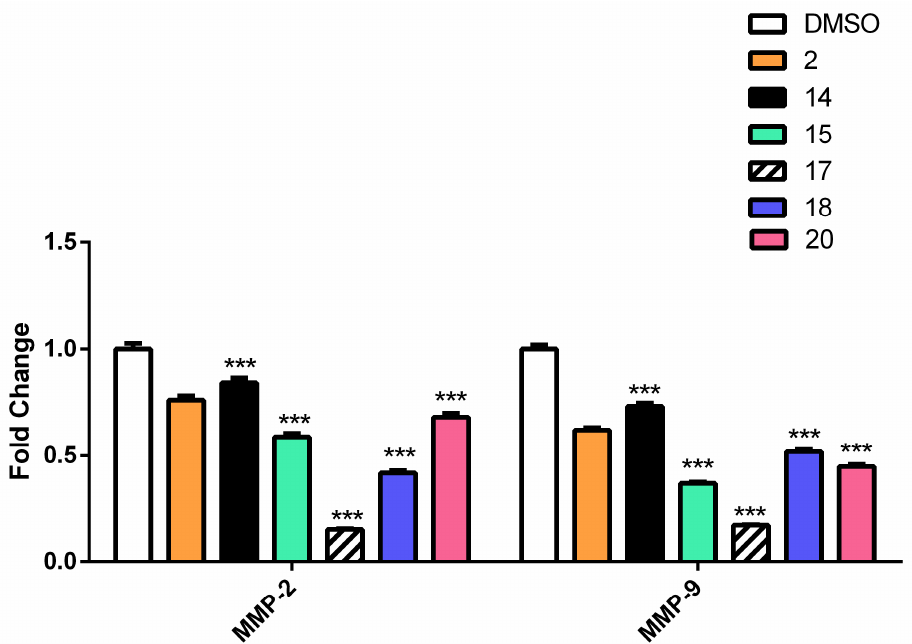
Figure 8. The effect of CA and its derivatives on the expression of MMP-2 and MMP-9 by RT-qPCR. The results were represented as mean of fold changes ± SD. β-actin gene was used as a control gene. ** Significant from CA at p < 0.01, *** Significant from CA at p < 0.001.